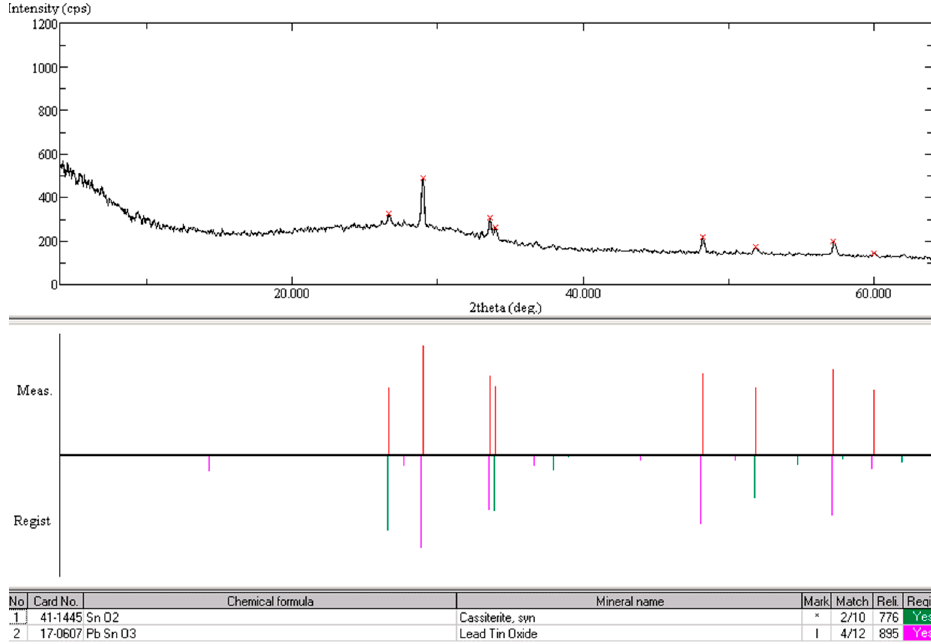
Figure 37. X-ray diffraction pattern of a green-colored tessera showing, in addition to PbSnO 3 , the presence of SnO 2 as well (DMS_1Ab green natron-based Egypt I glass tessera from the Great Mosque of Damascus Syria—unpublished data [24,25]).